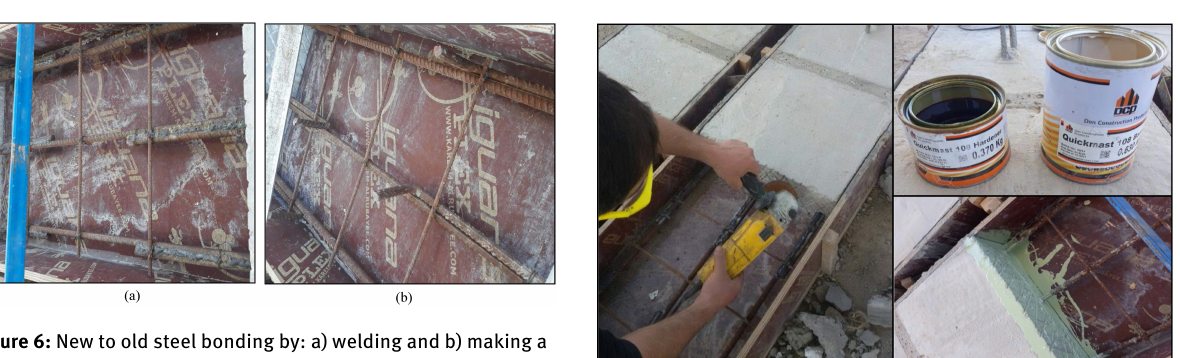
Figure 7: New steel mesh fixing by using epoxy.